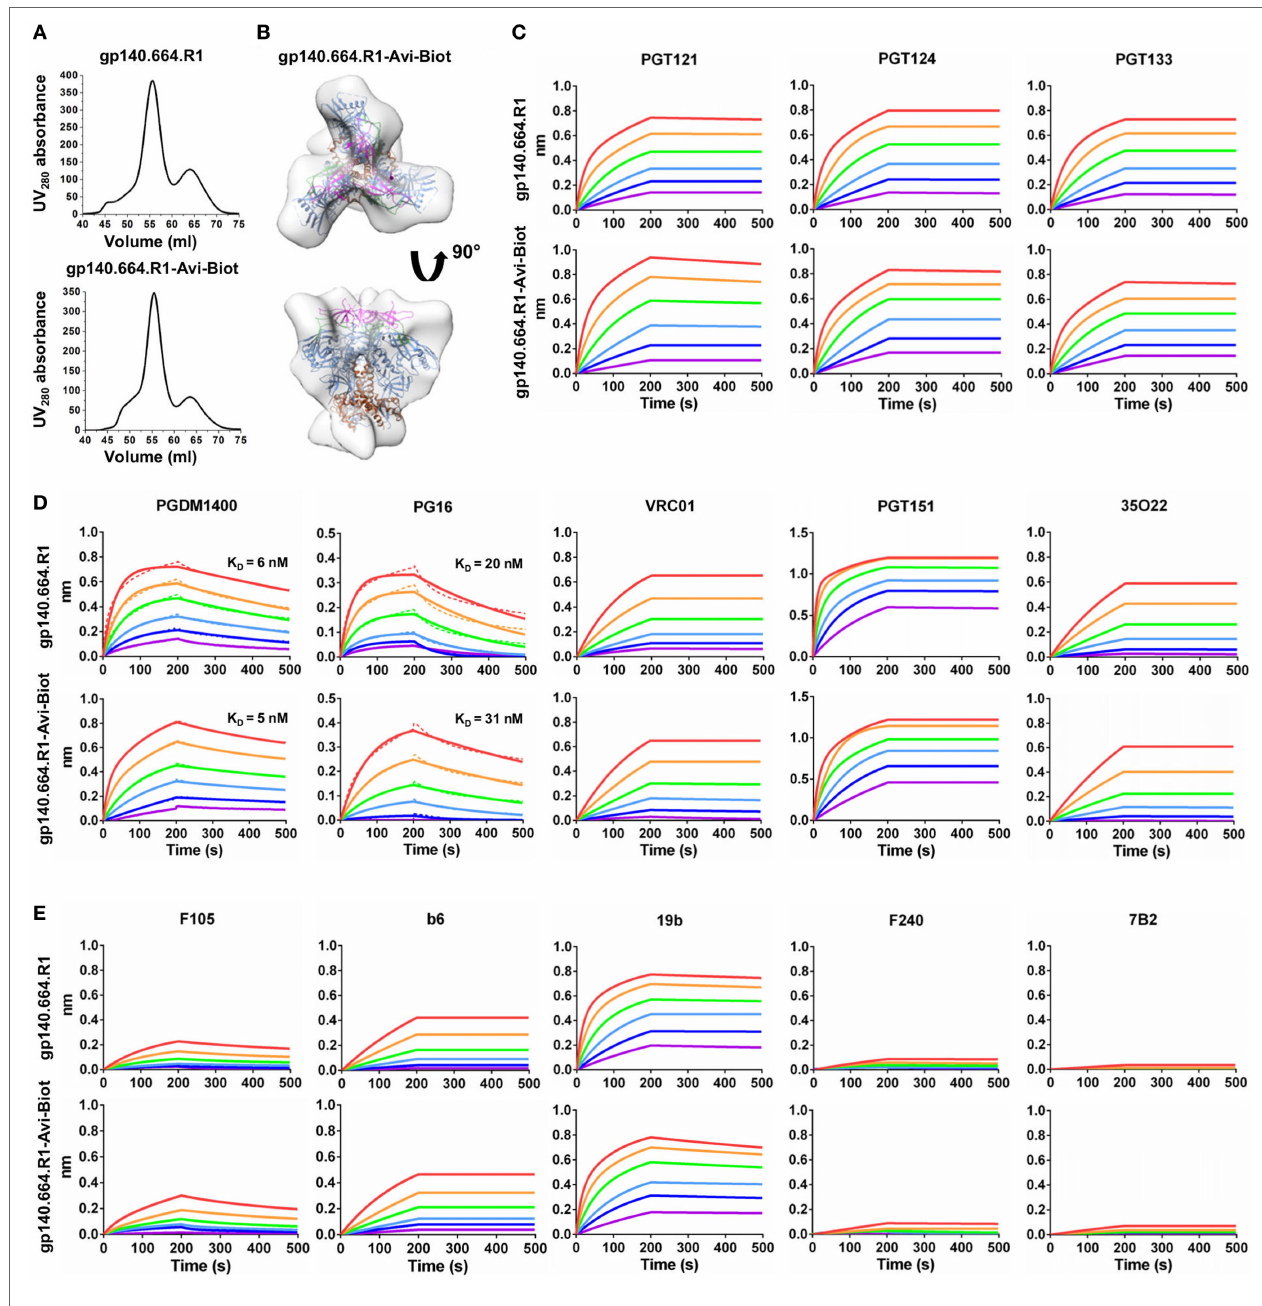
FigUre 1 | Biophysical characterization of a native-like, prefusion-optimized trimer probe. This trimer probe was designed based on a BG505 gp140 construct containing a redesigned heptad repeat 1 bend (termed gp140.664.R1). (a) Size-exclusion chromatography (SEC) profiles of 293F-expressed, Galanthus nivalis lectin (GNL)-purified gp140.664.R1 trimer (top) and biotinylated, Avi-tagged gp140.664.R1 trimer probe, termed gp140.664.R1-Avi-Biot (bottom), from a Superdex 200 16/600 column. (B) 3D reconstruction of the gp140.664.R1-Avi-Biot trimer probe derived from negative-stain electron microscopy (EM). The trimer densities are shown in gray transparent surface with the fitted crystal structure of the SOSIP trimer (PDB ID: 4TVP, gp120 in blue with V1V2 in magenta, V3 in green, and gp41 in brown). (c–e) Antigenic profiles of the gp140.664.R1 and gp140.664.R1-Avi-Biot trimers measured for (c) three broadly neutralizing antibodies (bNAbs) of the PGT121 class (PGT121, 124, and 133) isolated from donor-17, (D) five bNAbs targeting other sites of vulnerability on the HIV-1 envelope glycoprotein, and (e) five representative non-NAbs. Sensorgrams were obtained from an Octet RED96 instrument using a trimer titration series of six concentrations (200–6.25 nM by twofold dilution). K D values calculated from 1:1 global fitting are labeled for V1V2 apex-directed bNAbs (PGDM1400 and PG16) in panel (D)